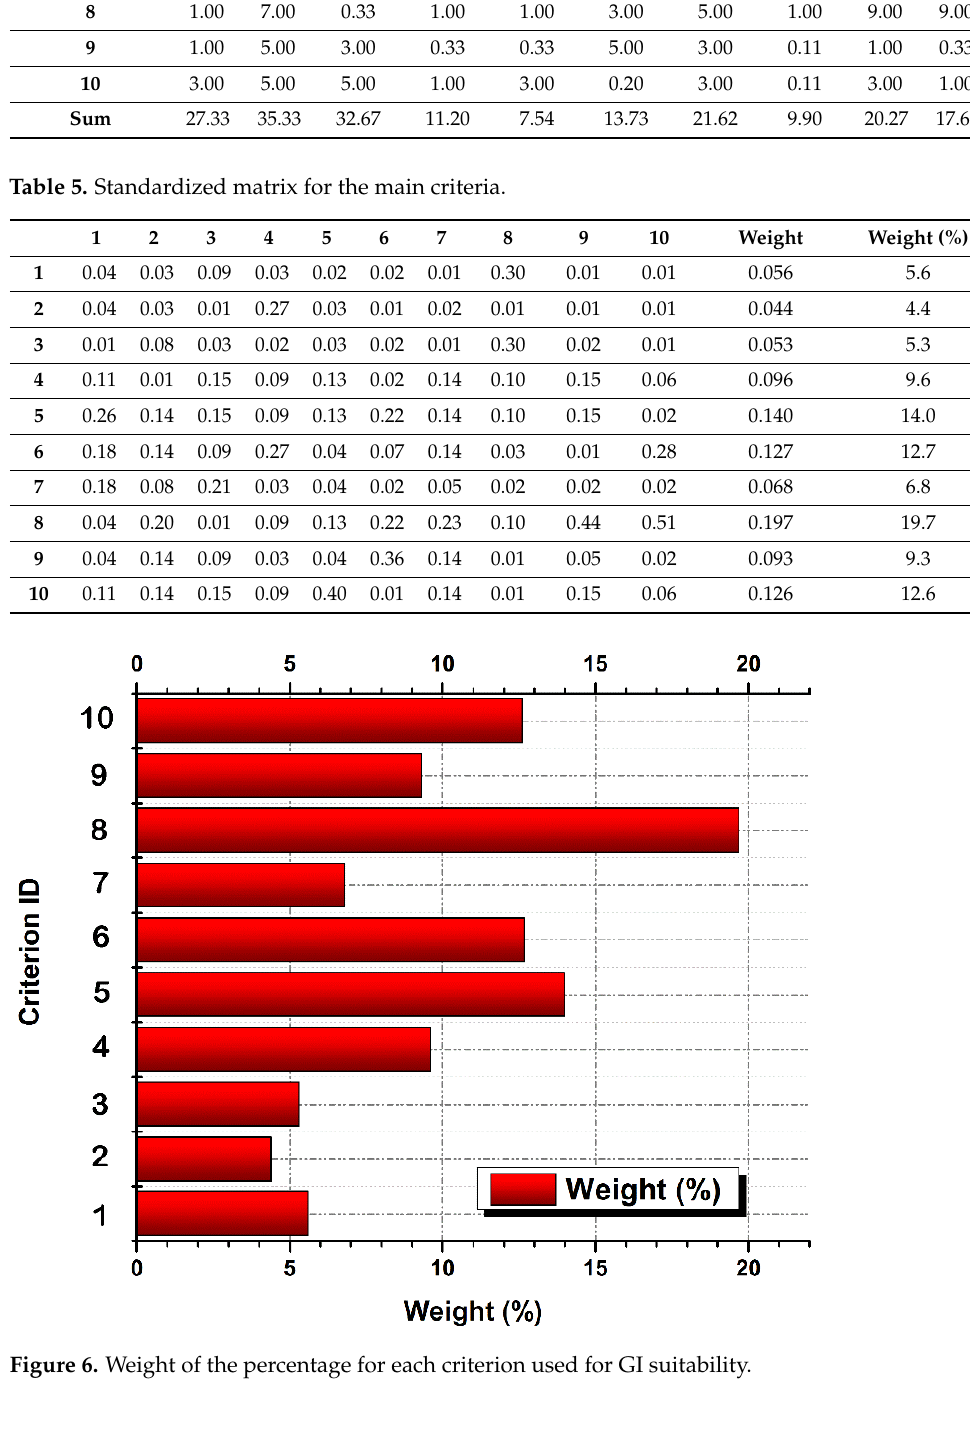
Table 6. The calculation of coherence index (CI) random consistency (CR).